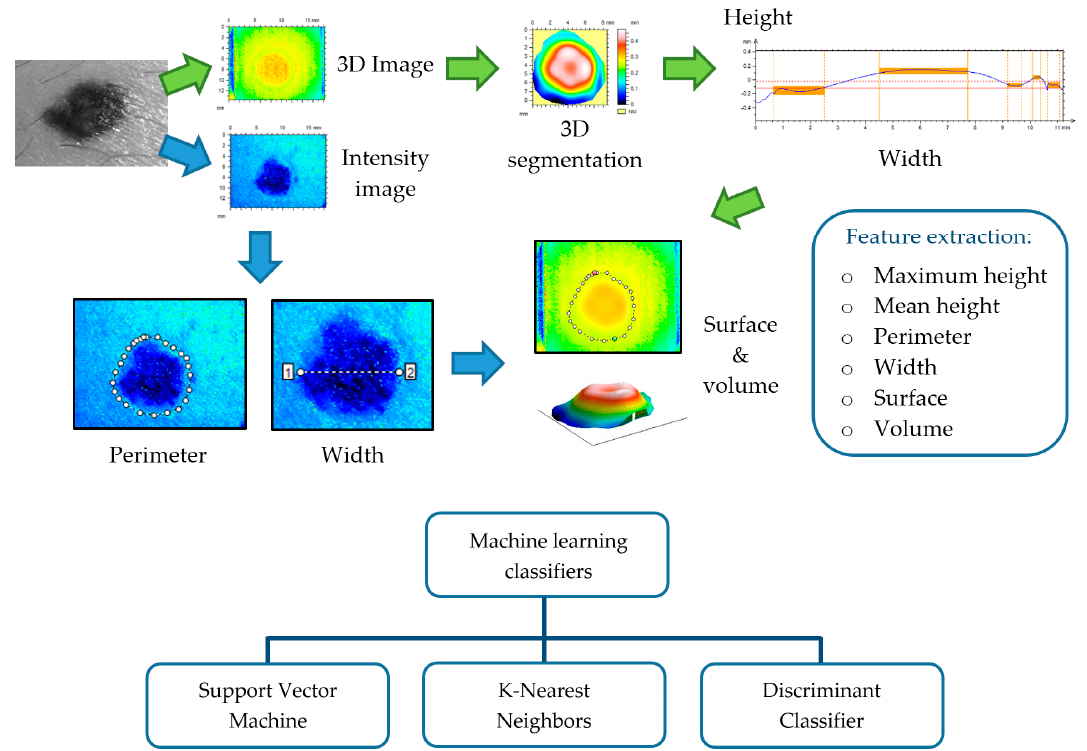
Figure 9. This illustrates the process of feature extraction, preceded by lesion segmentation from perilesional healthy skin, and feeding of machine learning classifiers with such features as descriptors.